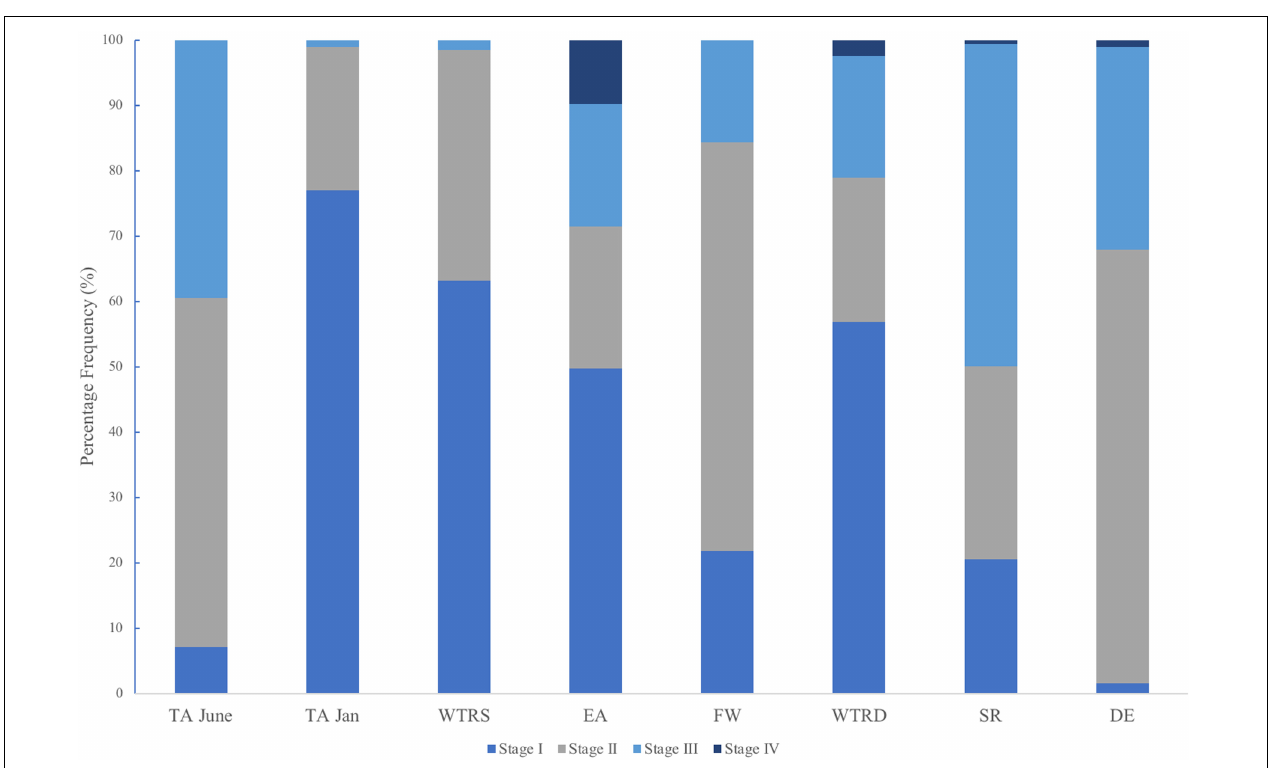
FIGURE 6 | Percent frequency distribution of each spermatocyst stage (I-IV) for each study site. Sites are arranged from shallowest (left) to deepest